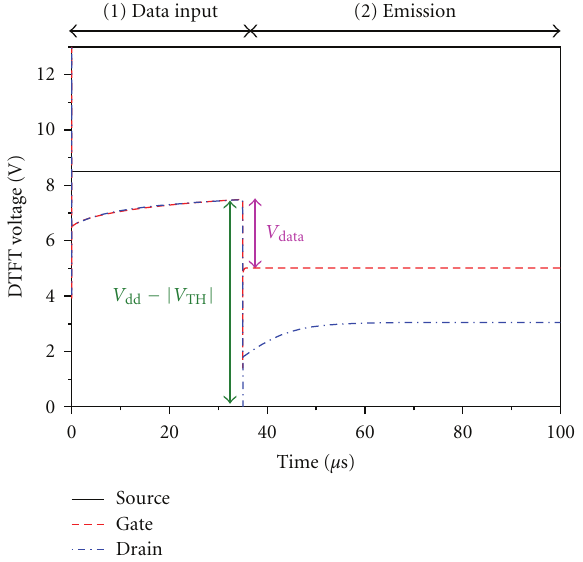
Figure 3: Gate, source, and drain voltages of driving TFT (DTFT) with operation stages: (1) Data input and compensation period; (2) Emission period when V data = 2 . 5V.